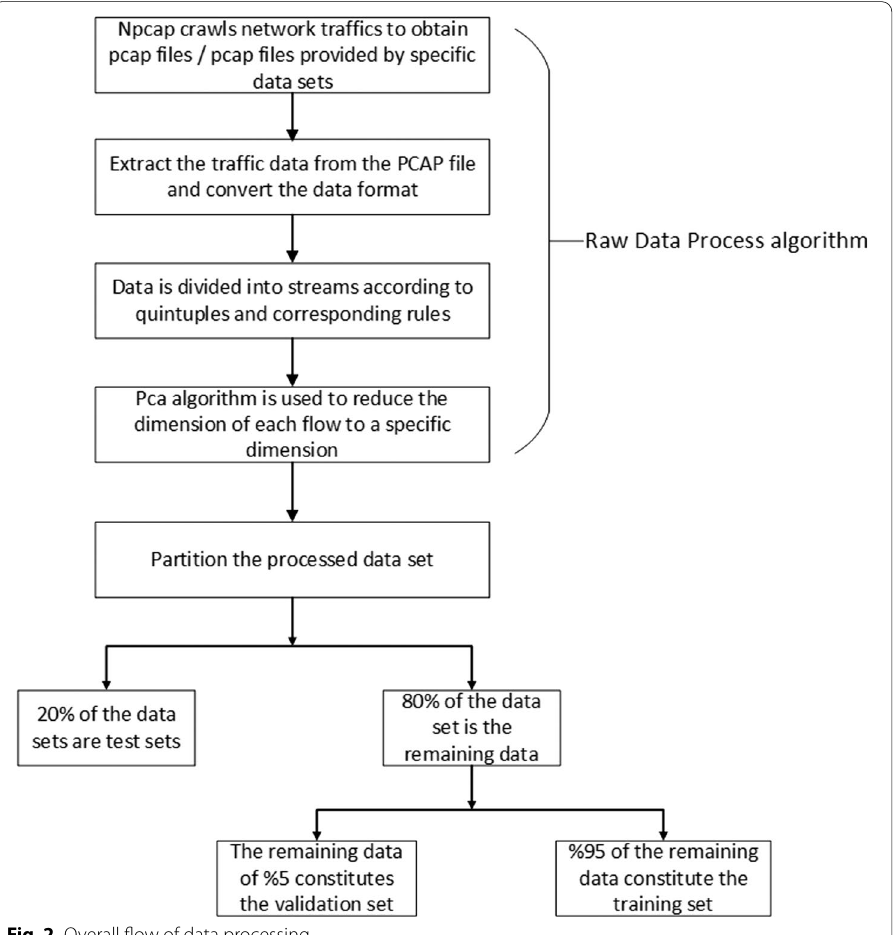
Fig. 2 Overall flow of data